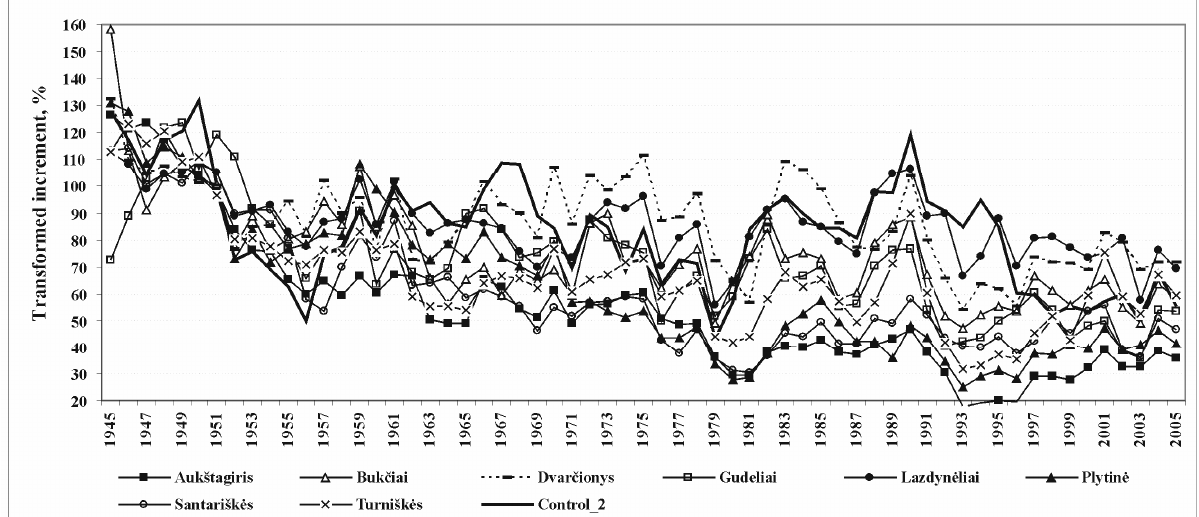
Fig. 5. Transformed dendroscales of 80 – 90 year old pines in Control_2 and Vilnius city sample plots